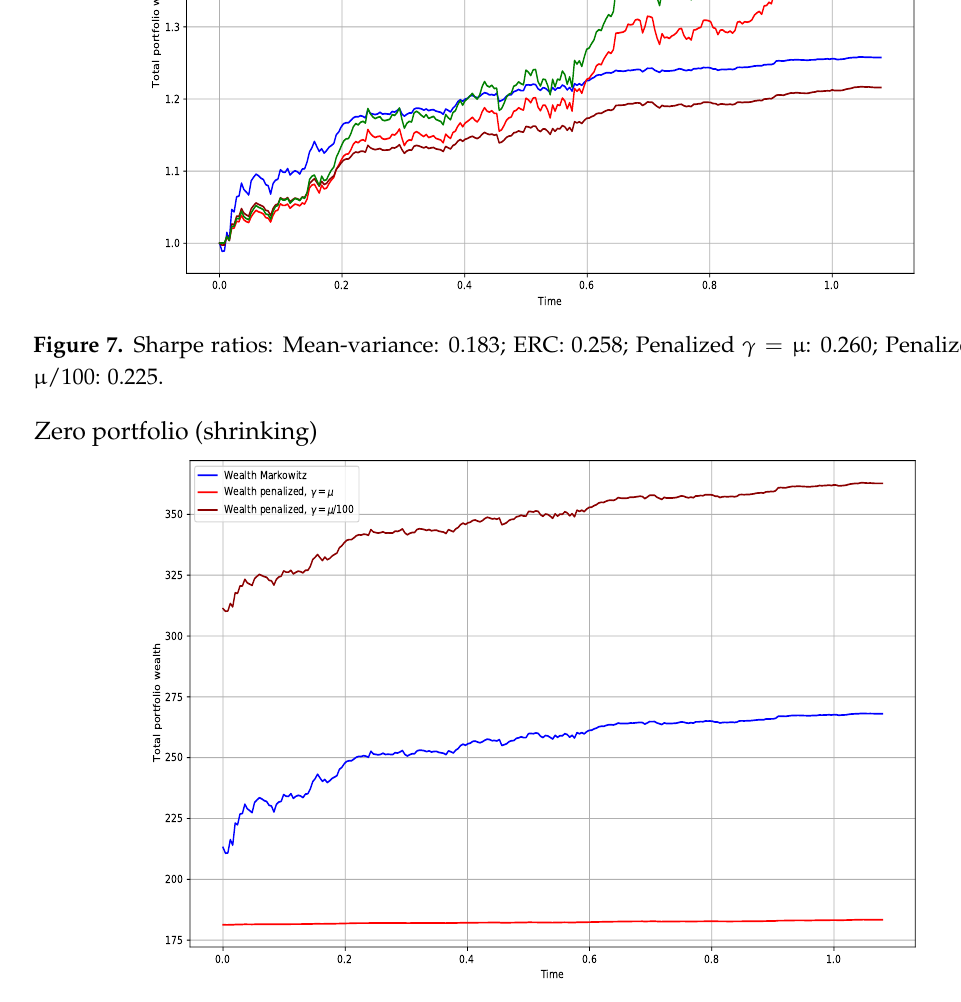
Figure 8. Total wealth of the mean-variance and penalized portfolios for γ = µ and γ = µ /100, normalized by the standard deviation of daily returns, as a function of time. Sharpe ratios: mean-variance: 0.183; Penalized γ = µ : 0.252; Penalized γ = µ /100: